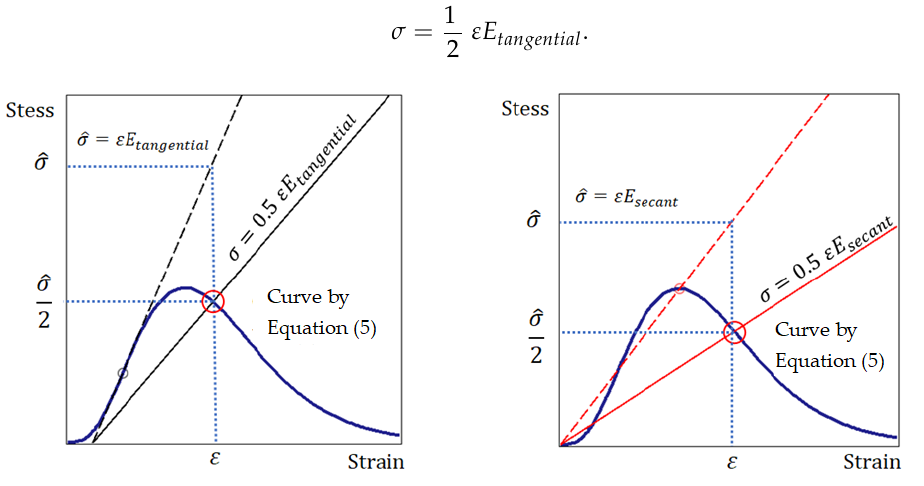
Figure 5. Fracture point on curve (5) (big red circle): using tangent ( left ) and secant modulus of elasticity ( right ).